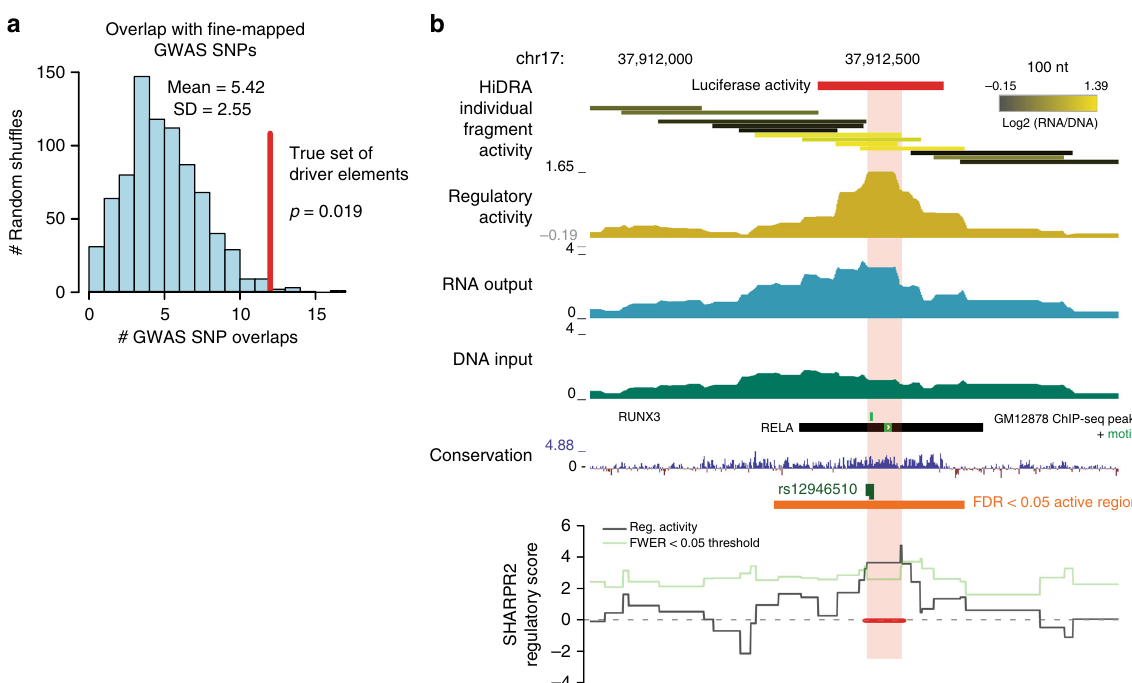
Fig. 5 High-resolution driver elements are enriched for fi ne-mapped GWAS SNPs. a Driver elements overlap more GWAS fi ne-mapped SNPs associated with 21 human immune-related complex traits than randomly shuf fl ed regions. p -value calculated empirically by random shuf fl ing of driver element positions within tiled regions. b Example locus at rs12946510 that overlaps a high-resolution driver element. Highlighted segment indicates the driver element identi fi ed at the regional FWER < 0.05. Red bar at top corresponds to region with luciferase activity as demonstrated by Hitomi et al.